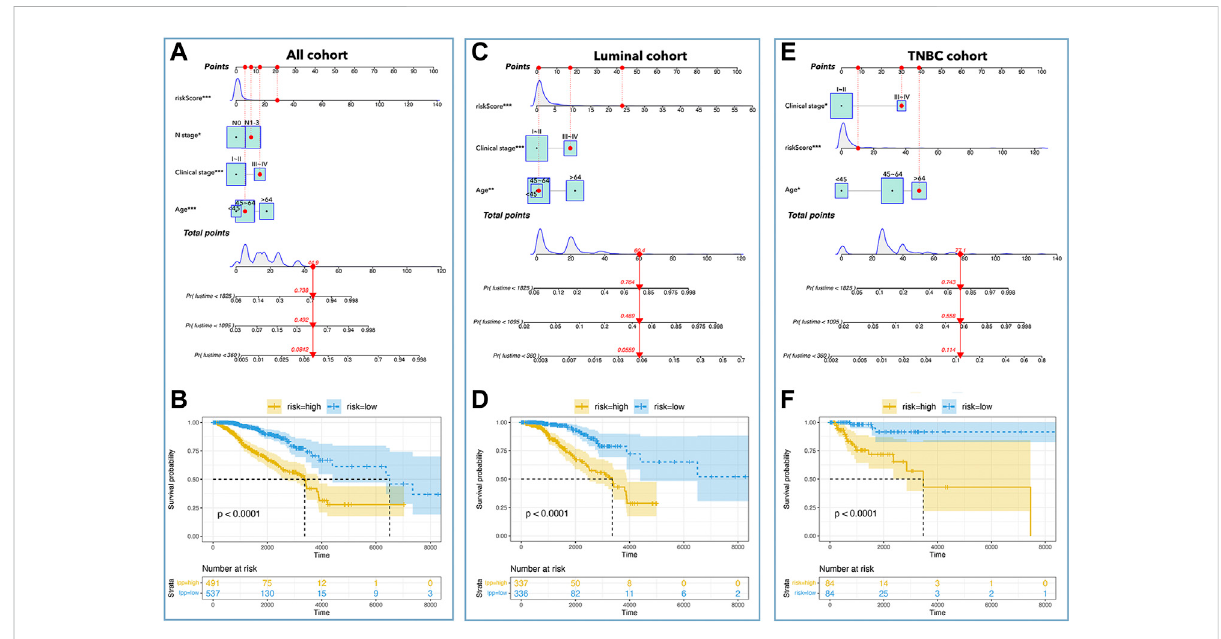
FIGURE 9 Nomogramsinsubtypesofbreastcancer.Nomogramsofallcohorts (A) ,luminalcohort (C) ,andTNBCcohort (E) .TheK-Mcurveshowedthata low-risk-score had better prognosis in all cohorts (B) , luminal cohort (D) , and TNBC cohort (F) .